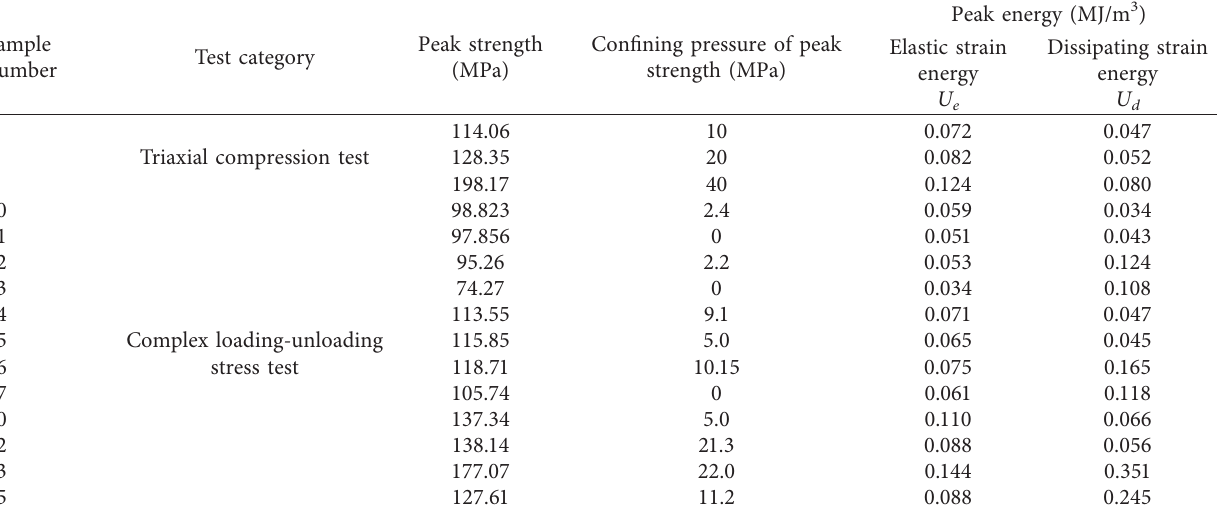
Figure 3: Stress-strain curves in triaxial compression Table 3: Test results of different samples.